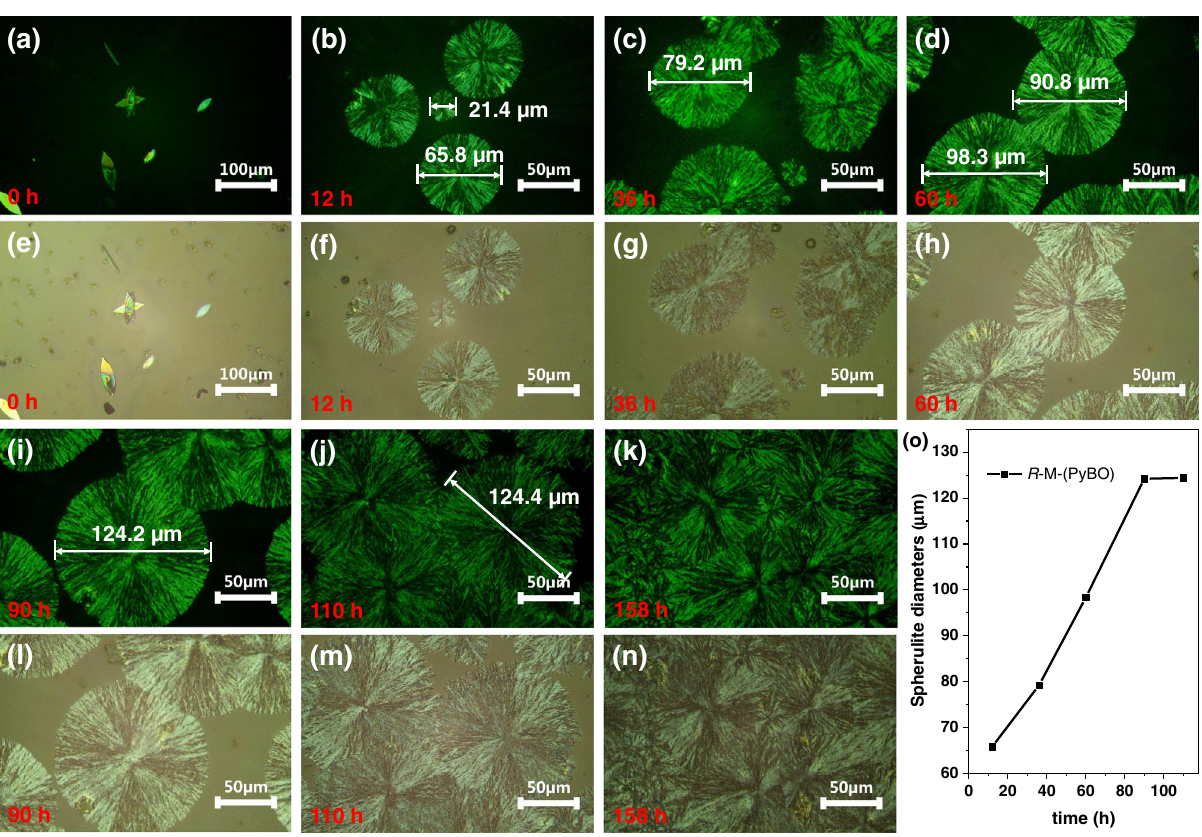
Fig.4|POMandopticalmicroscopeimages.a – d , i – k POMimagesof R -M-(PyBO) 4 ; e – h , l – n Opticalmicroscopeimagesof R -M-(PyBO) 4 ; o Plotofspherulitediametersof R -M-(PyBO) 4 vs time (h) in air. All spin-coated fi lms from toluene solution (40mg/mL) on quartz plates (1cm×3cm) (1000N/s,